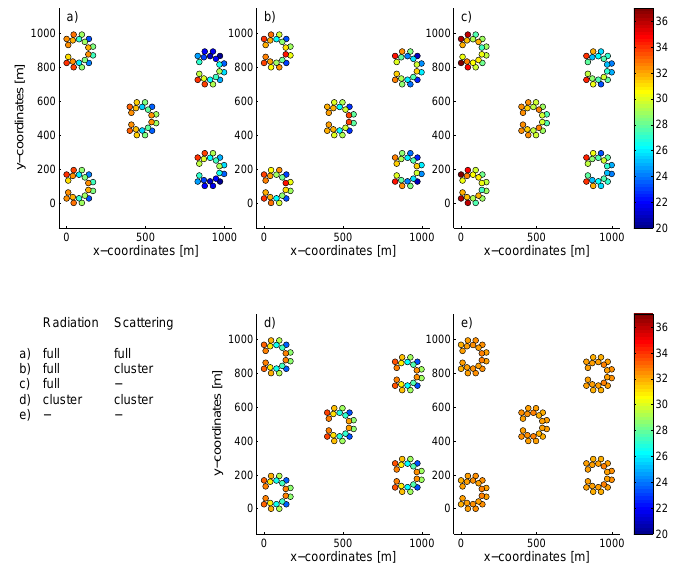
Figure 3. Farm of 100 WECs divided into five clusters. The capture width ratio in % for each WEC is shown with the color bar. The hydrodynamic interaction between the devices has been computed in five different ways with decreasing accuracy, shown in the table. ( a ) Full interaction is computed between all devices for diffracted and radiated waves; ( b ) Radiated waves between all WECs are taken into account, but diffraction is computed only within each cluster; ( c ) All WECs interact with radiated waves, but no multiple diffraction interaction is included; ( d ) Interaction is computed only within the cluster, both for radiated and diffracted waves; ( e ) No hydrodynamic interaction between the devices.